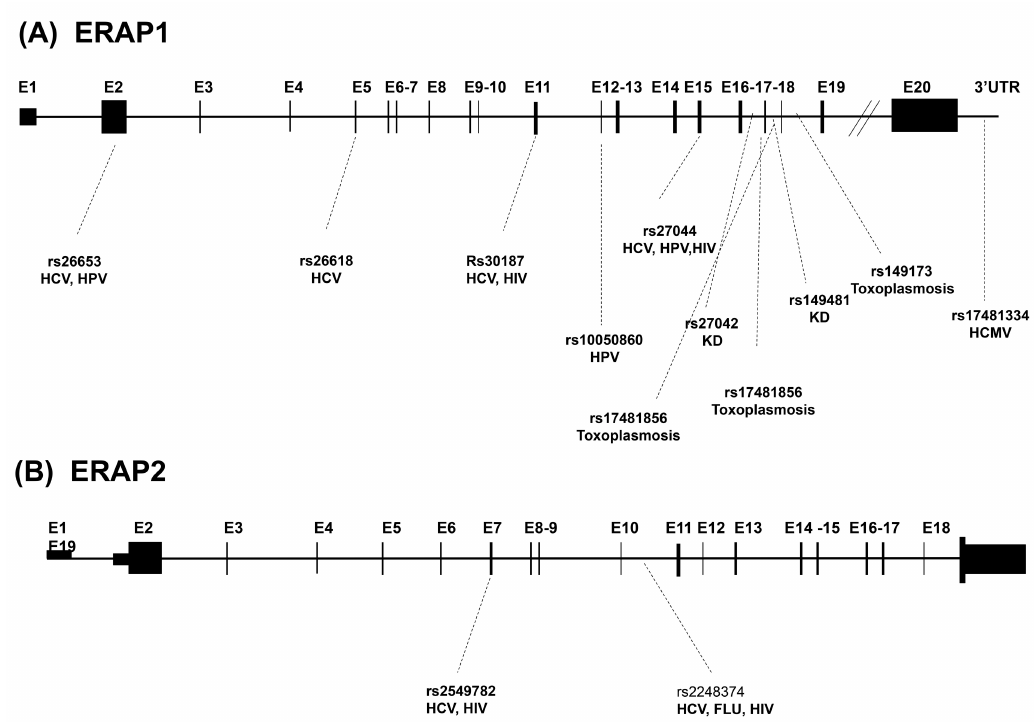
Figure 1. Genomic structure of the human ERAP1 ( A ) and ERAP2 ( B ) genes. Exons are numbered and depicted as boxes. Outlines indicate the sites of exonic or intronic polymorphisms described in the text as rs and related infections.